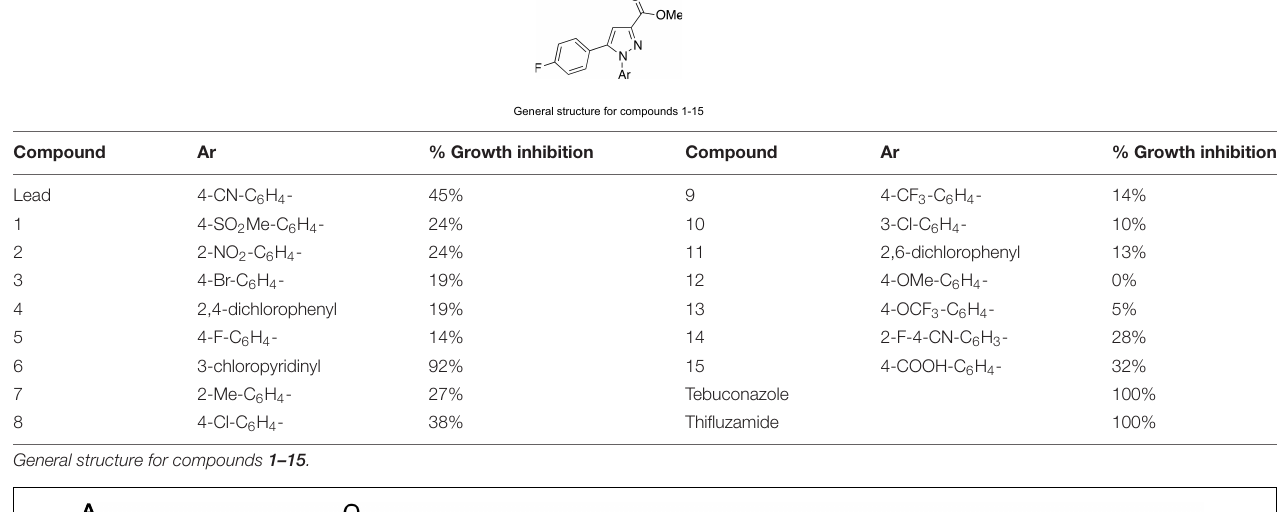
TABLE 1 | Inhibition rate of compound 3c and its derivatives against S. rolfsii at 100 µ g/ml.